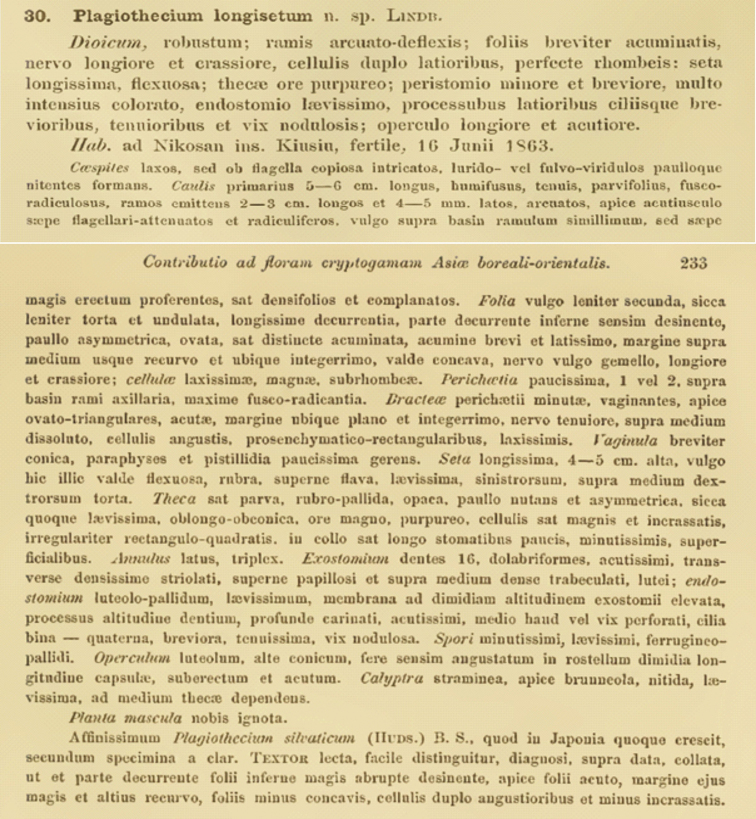
The diagnosis of Plagiothecium
longisetum (Lindberg 1872).